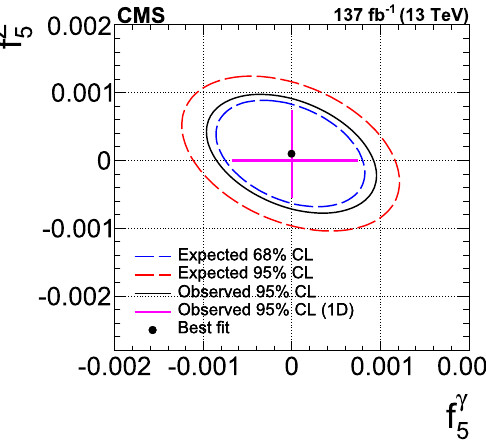
Fig. 8 Two-dimensional observed (solid) and expected (dashed) con- tours exclusion limits at 95% CL, and at 68 and 95% CL, respectively, on the ZZZ and ZZ γ aTGCs. The plots show the exclusion contours , f γ ) parameter planes. Dots show where the likelihoods in the ( f Z 4 ( 5 ) 4 ( 5 )